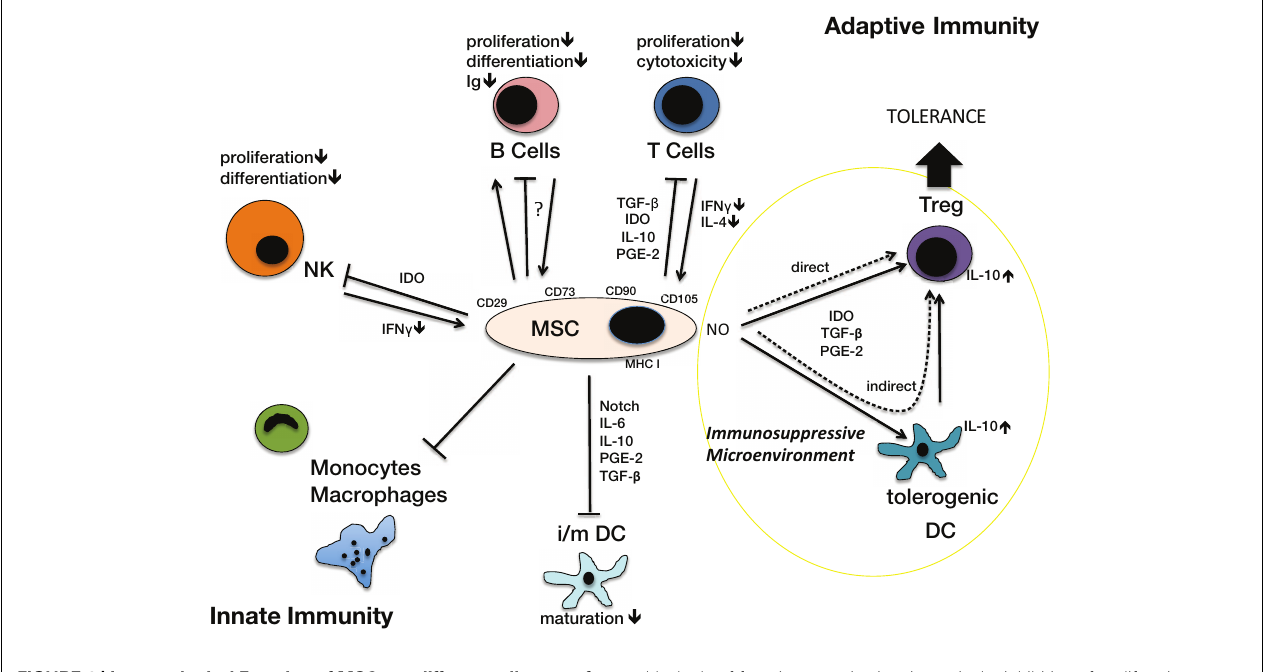
FIGURE 1 | Immunological Function of MSCs on different cell types of the innate and adaptive immunosystem . MSC, mesenchymal stromal cell, characterized by surface antigens CD29, CD73, CD90 (CD105), MHC I; cell types: B cells,T Cells,Treg; regulatoryT cells; DC, dendritic cells (tolerogenic, i/m, immature/mature), monocytes, macrophages, NK, natural killer cells. Arrows indicate activation or induction,T-bars indicate